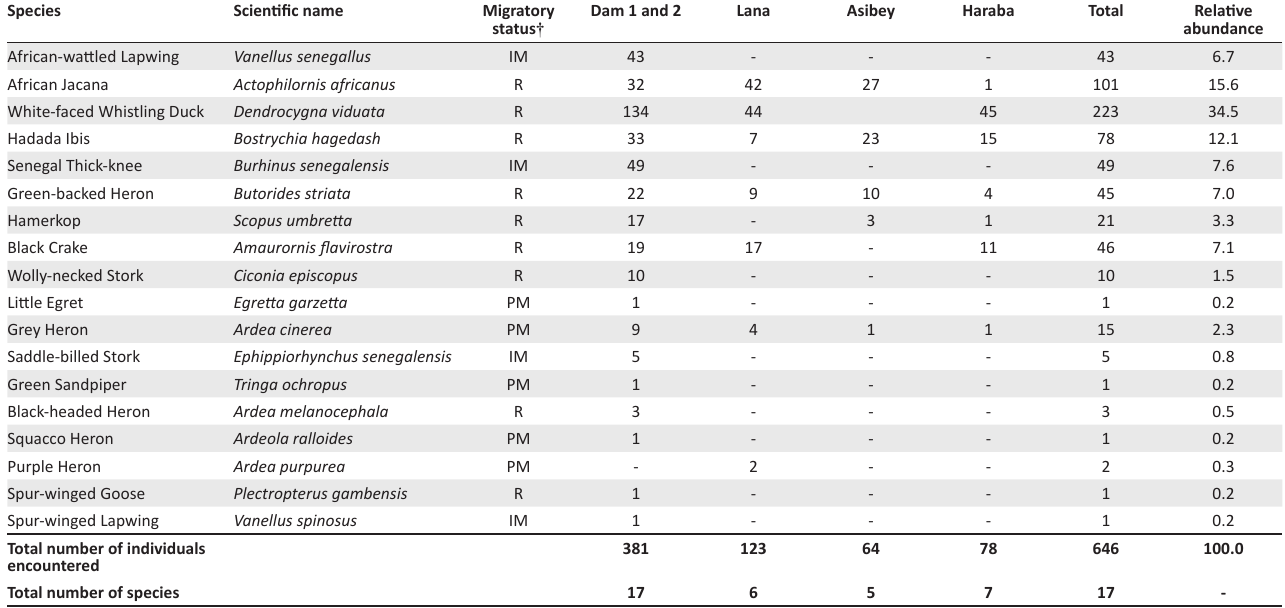
TABLE 1: Species diversity and relative abundance of waterbirds in the wet season at Mole National Park.